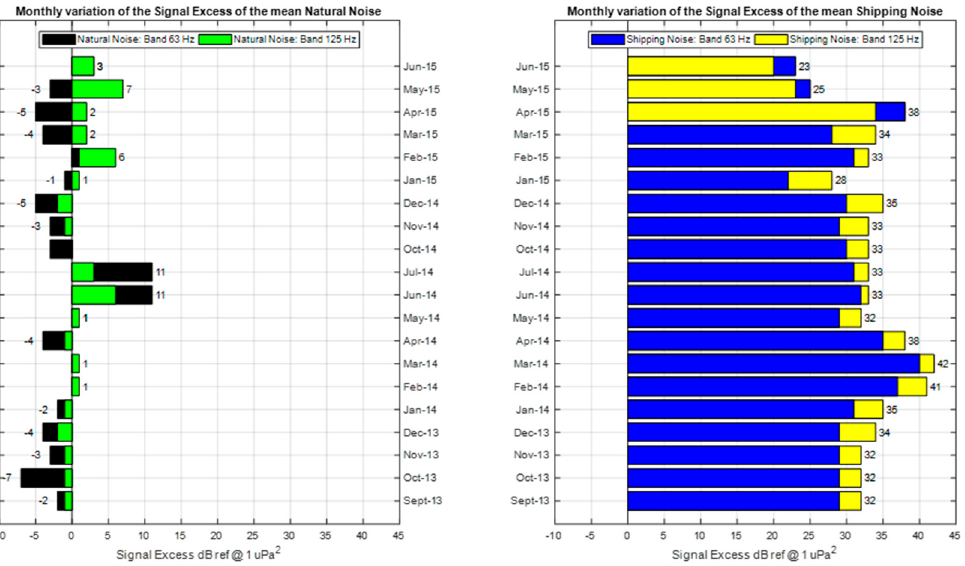
Figure 15. Monthly variation in the signal excess referenced at 100 dB of the averaged maximum of the 1/3 octave bands centered at 63 and 125 Hz: natural noise ( left ) and shipping noise ( right ) measurements.